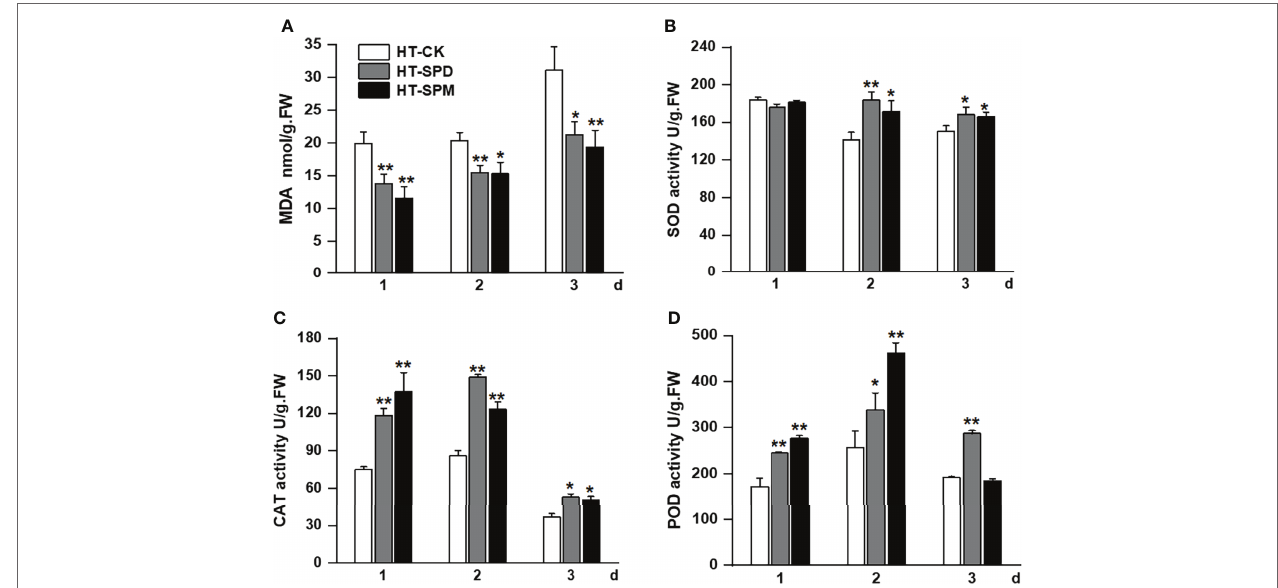
FIGURE 5 | Effect of PA on malondialdehyde (MDA) content and antioxidant activity under HT stress. (A) MDA contents, (B) superoxide dismutase (SOD) activities, (C) catalase (CAT) activities, and (D) peroxidase (POD) activities of G lemaneiformis under HT stress treatment. Data presented are the means ± SD from three